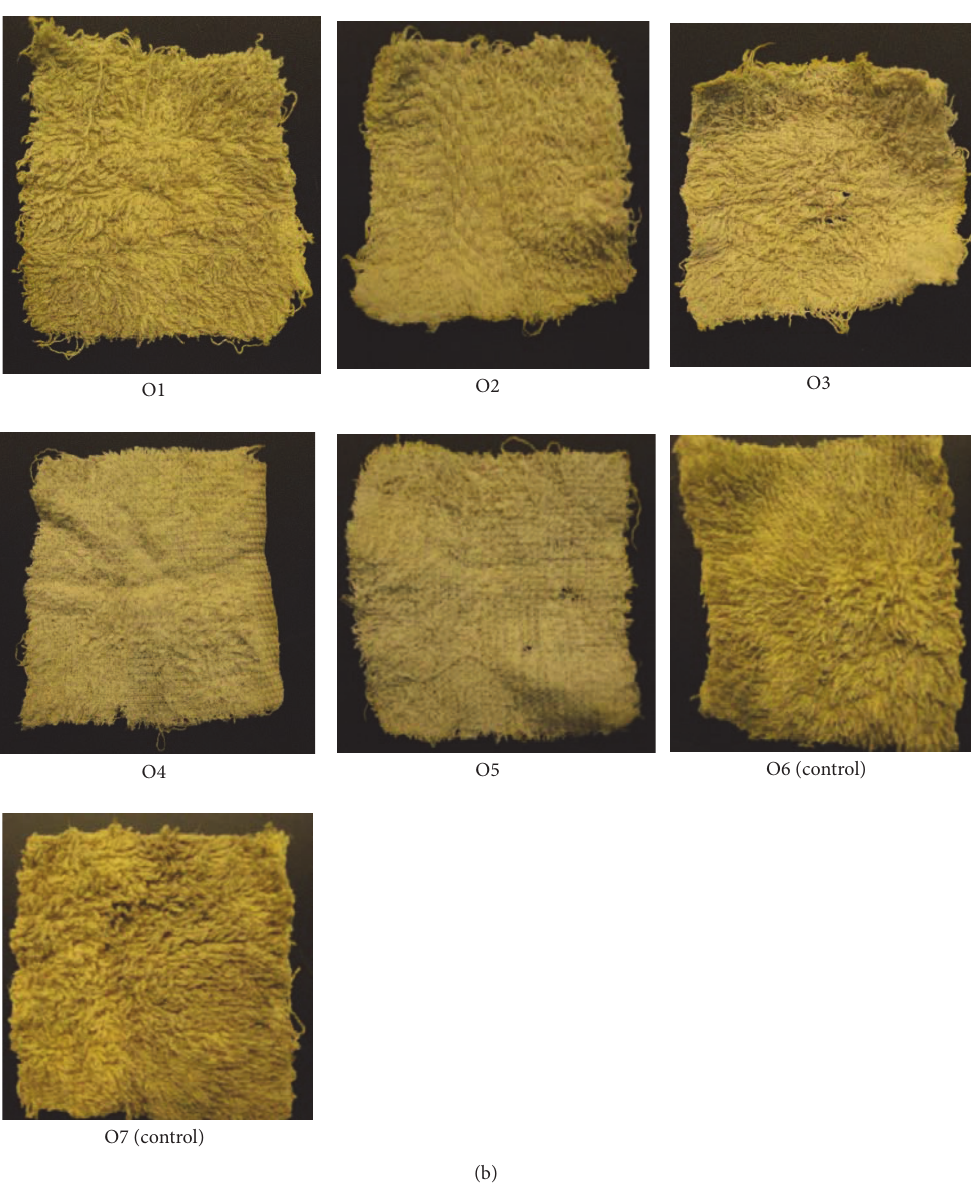
Figure 3: (a) Images of DBSCC samples to demonstrate the effects of EHOs formulations (without pH adjustment) on brightness of cloth fabric. Note: An alphabetical integer value represents composition of detergent formulation as listed in Table 2. (b) Closed visual images of dried cloth samples resulted from EHOs formulations (without pH adjustment). Note: A positive integer value represents compositions of different detergent formulation as listed in Table